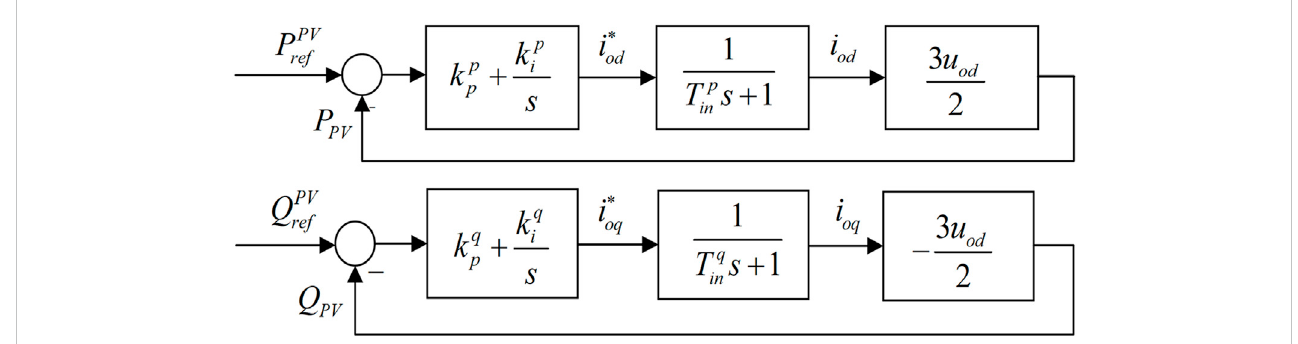
FIGURE 3 PQ control block diagram of the DPV